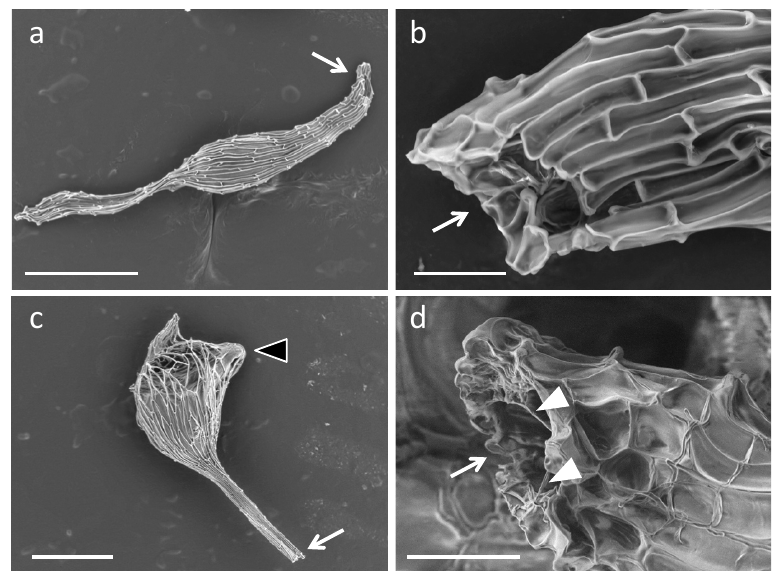
Figure 5. SEM images of Bletilla striata inoculated with a symbiotic fungus Tulasnella sp. strain HR1-1. The images show B. striata seeds before sowing ( a , b ) and the germinated seeds inoculated with Tulasnella sp. strain HR1-1 ( c , d ). Arrows indicate a hole at the end of seed coat. The black arrow head indicates a shoot apical meristem. The white arrow heads indicate fungal hyphae. Scale bars, 500 µm ( a , c ) and 50 µm ( b , d ).